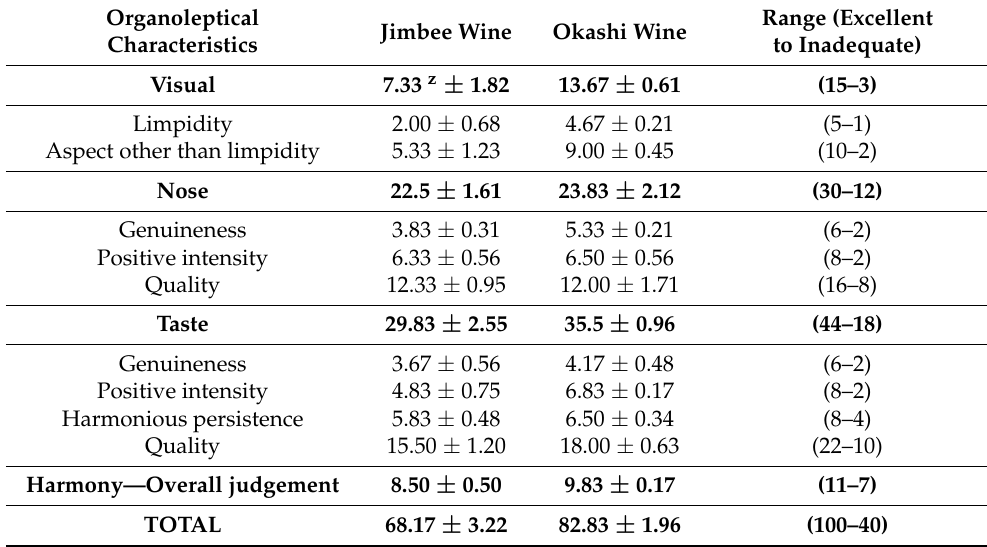
Table 7. Sensory evaluation of the Jimbee and Okashi melon